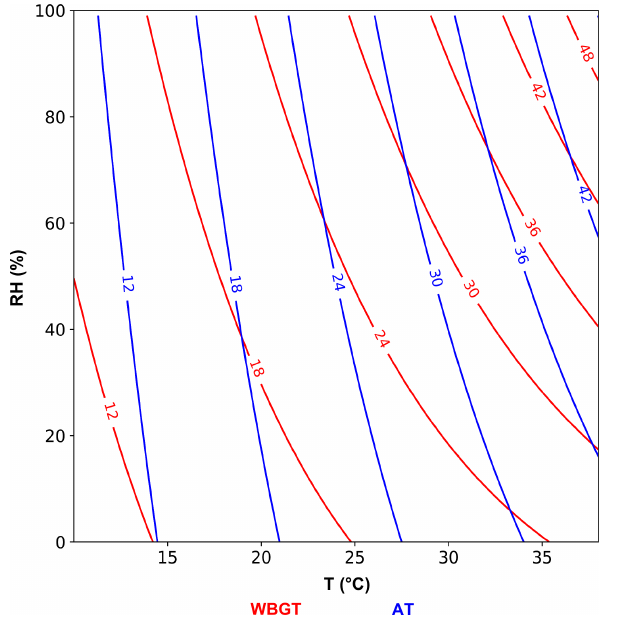
Figure 1. Contours lines of equal-level heat-stress indicators: WBGT (red) and AT